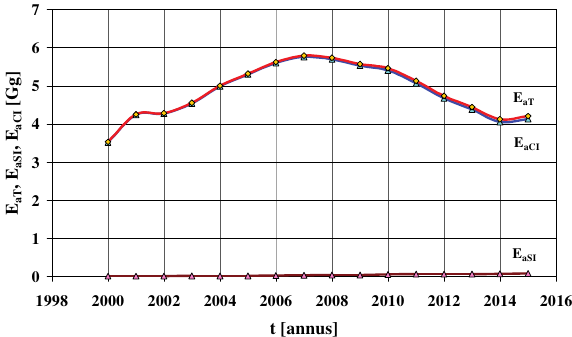
Fig. 14. National annual emission of particulate matter from the exhaust system of passenger car engines